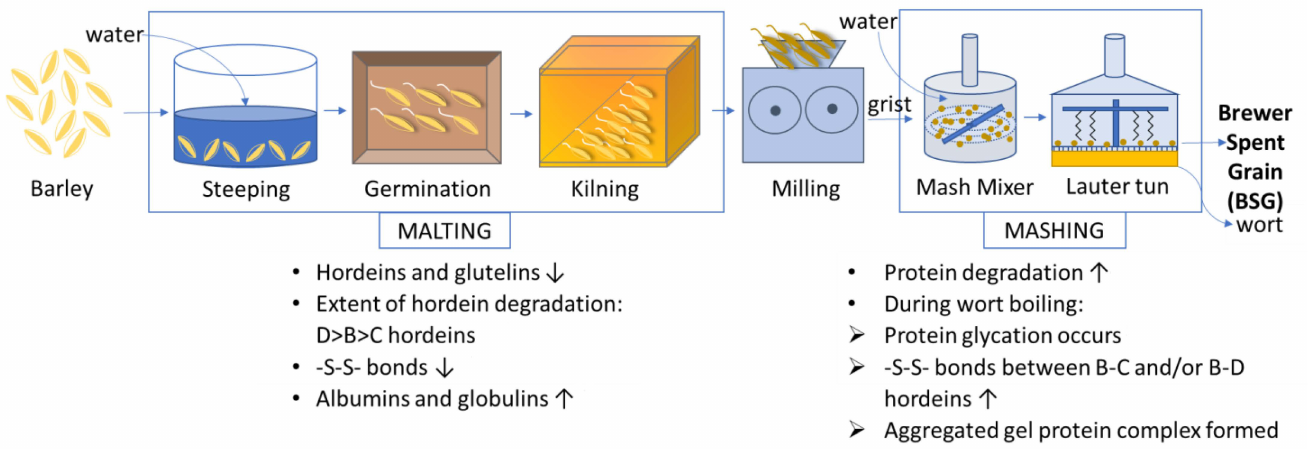
Figure 1. Protein compositional and structural changes during conversion of barley to BSG. Informa- tion adapted from: Osman et al., 2002 [25]; Marchylo et al., 1986 [29]; Tatham and Shewry, 1995 [30]; Wallace and Lance, 1988 [31]; Celus et al., 2006 [16]; Jones and Marinac, 2002 [28]; Steiner et al., 2011 [20]; Smith and Lister, 1983 [26]; Smith and Simpson, 1983